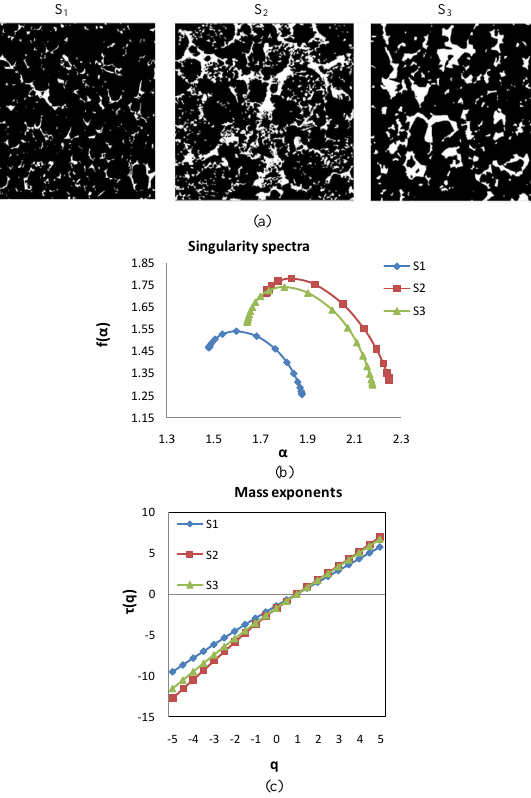
Figure 11. Plots of the detected pore spaces for samples S 1 , S 2 and S 3 (a) and their associated singularity spectra f(α) (b), and mass exponents (c).